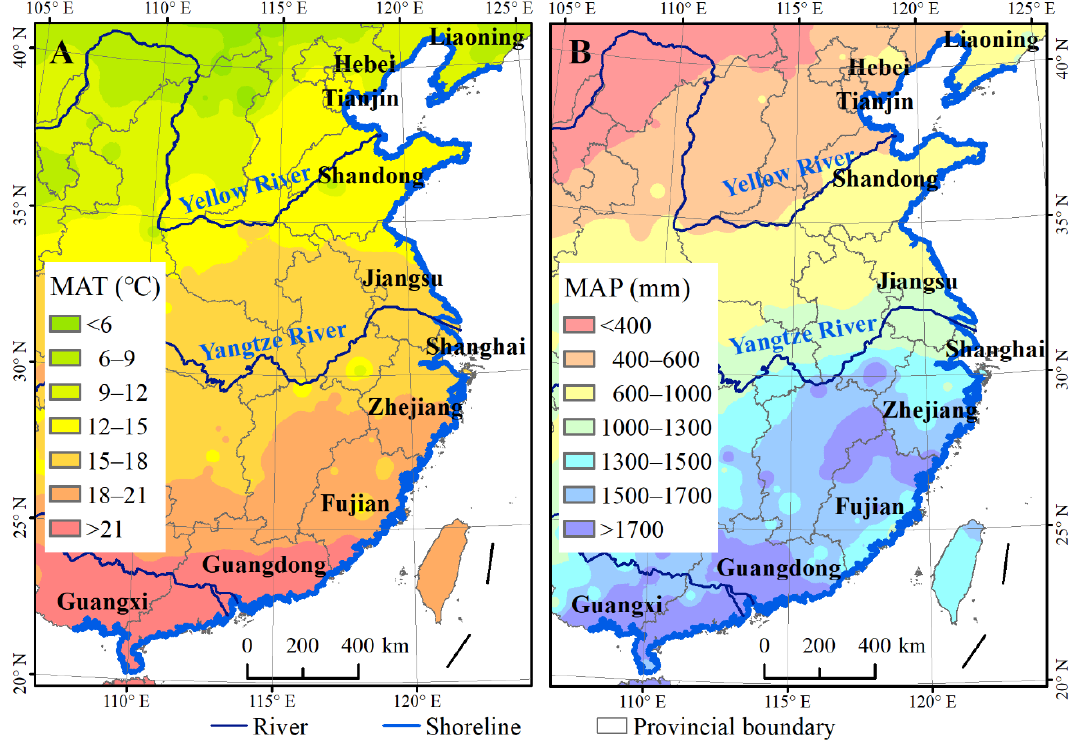
Figure 1. Geographic location and climatic gradients of the study area: ( A ), mean annual temperature (MAT); ( B ), mean annual precipitation (MAP).